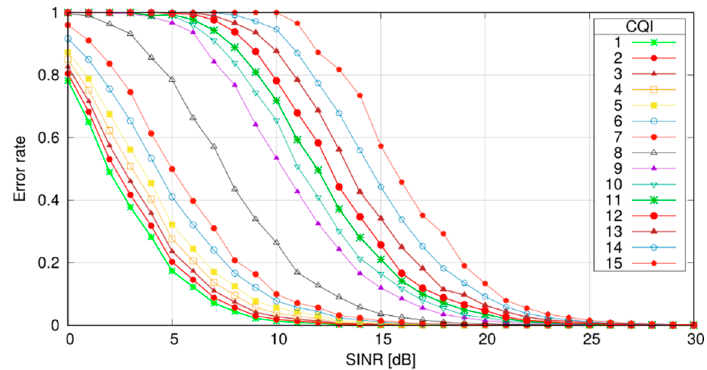
Figure 6. Example of BLER curves.